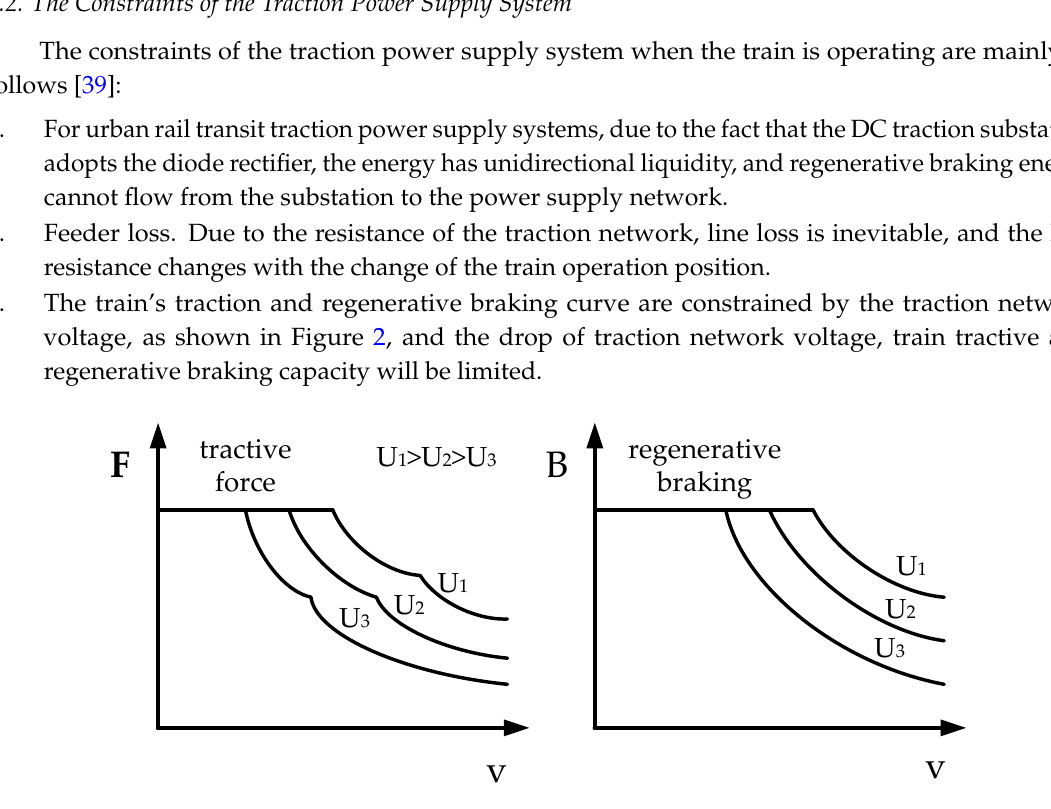
Figure 1. Schematic diagram of the urban rail transit power supply system. TSS, traction substation.